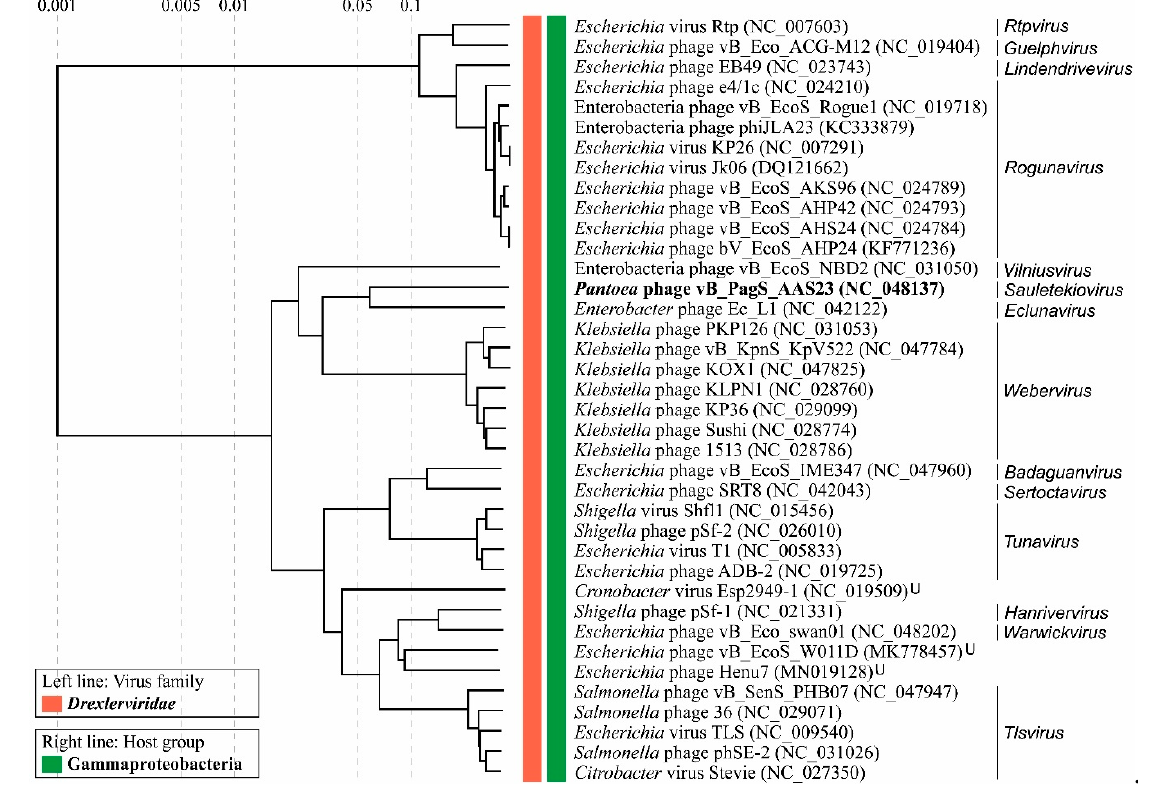
Figure 5. ViPTree generated proteomic tree of Pantoea phage vB_PagS_AAS23 and dsDNA viruses represented in the rectangular view. The tree is constructed by BIONJ based on genomic distance matrixes, and mid-point rooted. Branch lengths are logarithmically scaled from the root of the entire proteomic tree. The numbers at the top represent the log-scaled branch lengths based on the SG (normalized tBLASTx scores) values.